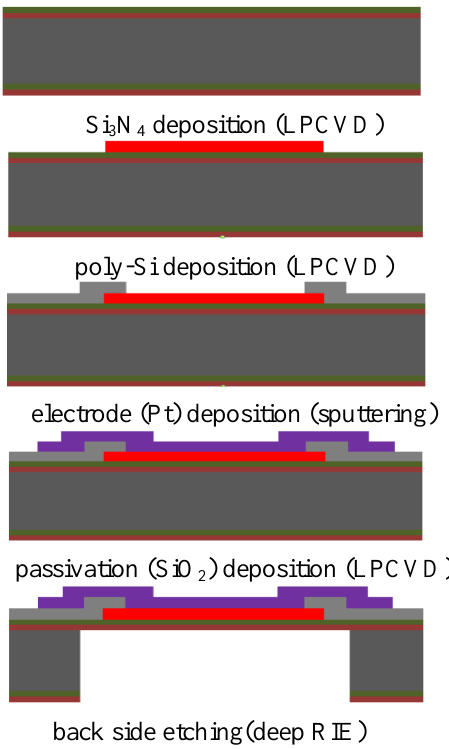
Figure 4. The fabrication process of the MEMS micro-heater.